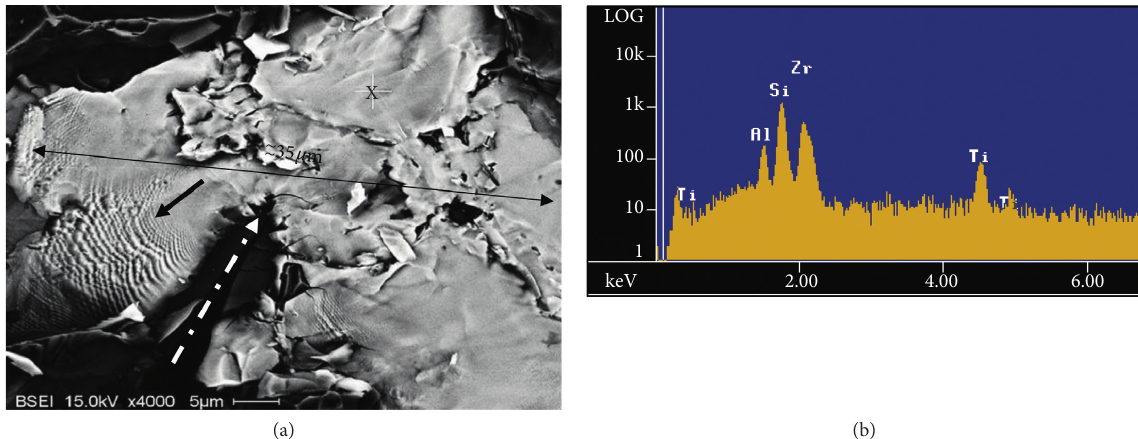
Figure 14: (a) Backscattered electron micrograph of alloy D after solutionizing treatment (4.5%El) and (b) EDS spectrum corresponding to the area marked X in (a), (Al, Si) 2 (Zr,Ti) phase.